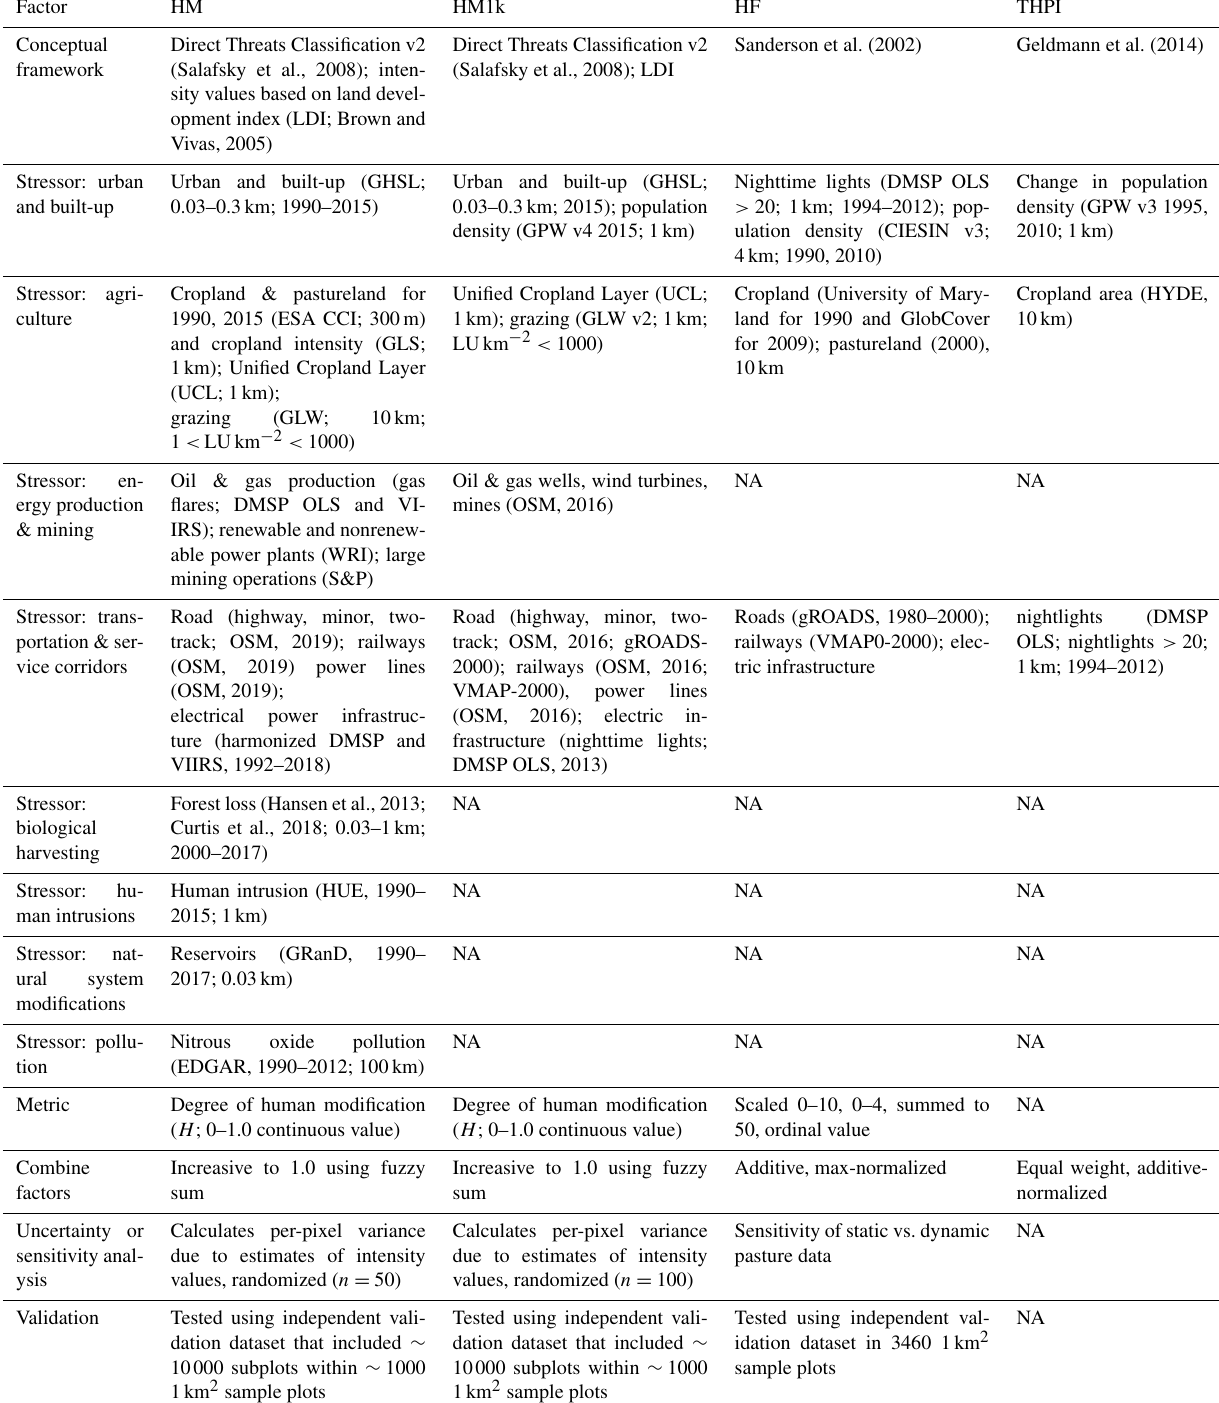
Table 6. A summary of the data, methods, and results comparing the degree of human modification (HM; this paper), degree of human modification 1km (HM1k; Kennedy et al., 2019a, b, c), human footprint (HF; Sanderson et al., 2002; Venter et al., 2016), and temporal human pressure index (THPI; Geldmann et al., 2019b). Also see discussion of comparison in Kennedy et al. (2019a, c), Venter et al. (2019), and Riggio et al. (2020). Data source acronyms are provided in Table